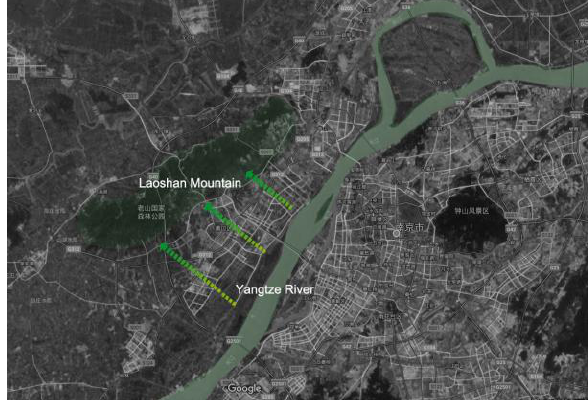
Figure 3 Green axis of Jiangbei New